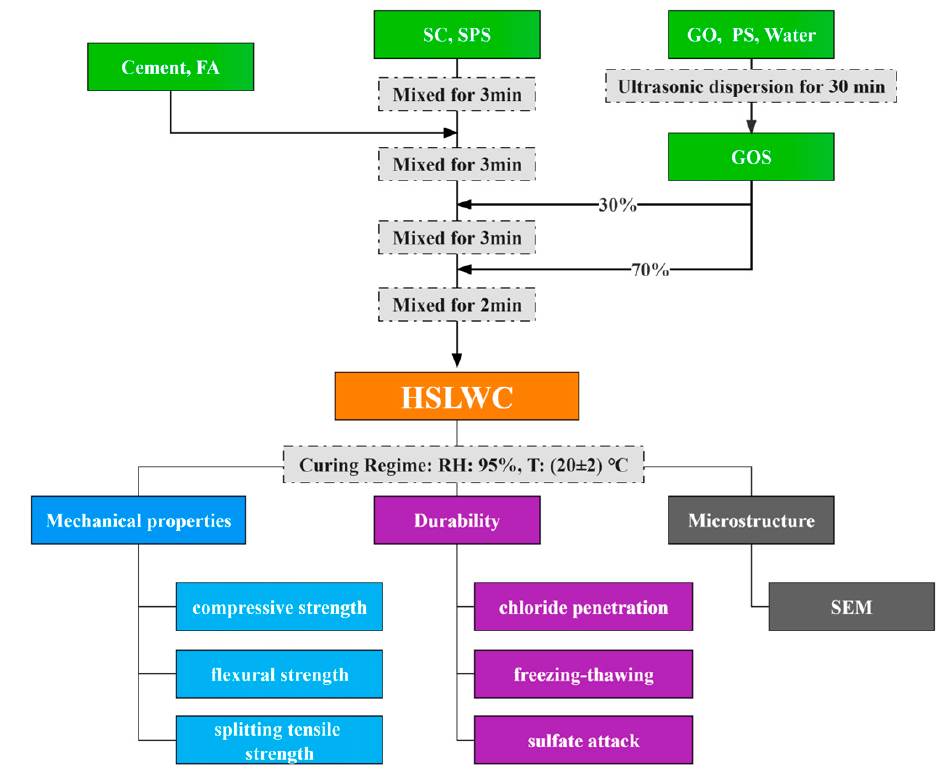
Figure 4. Mixing procedure and experimental items of HSLWC.